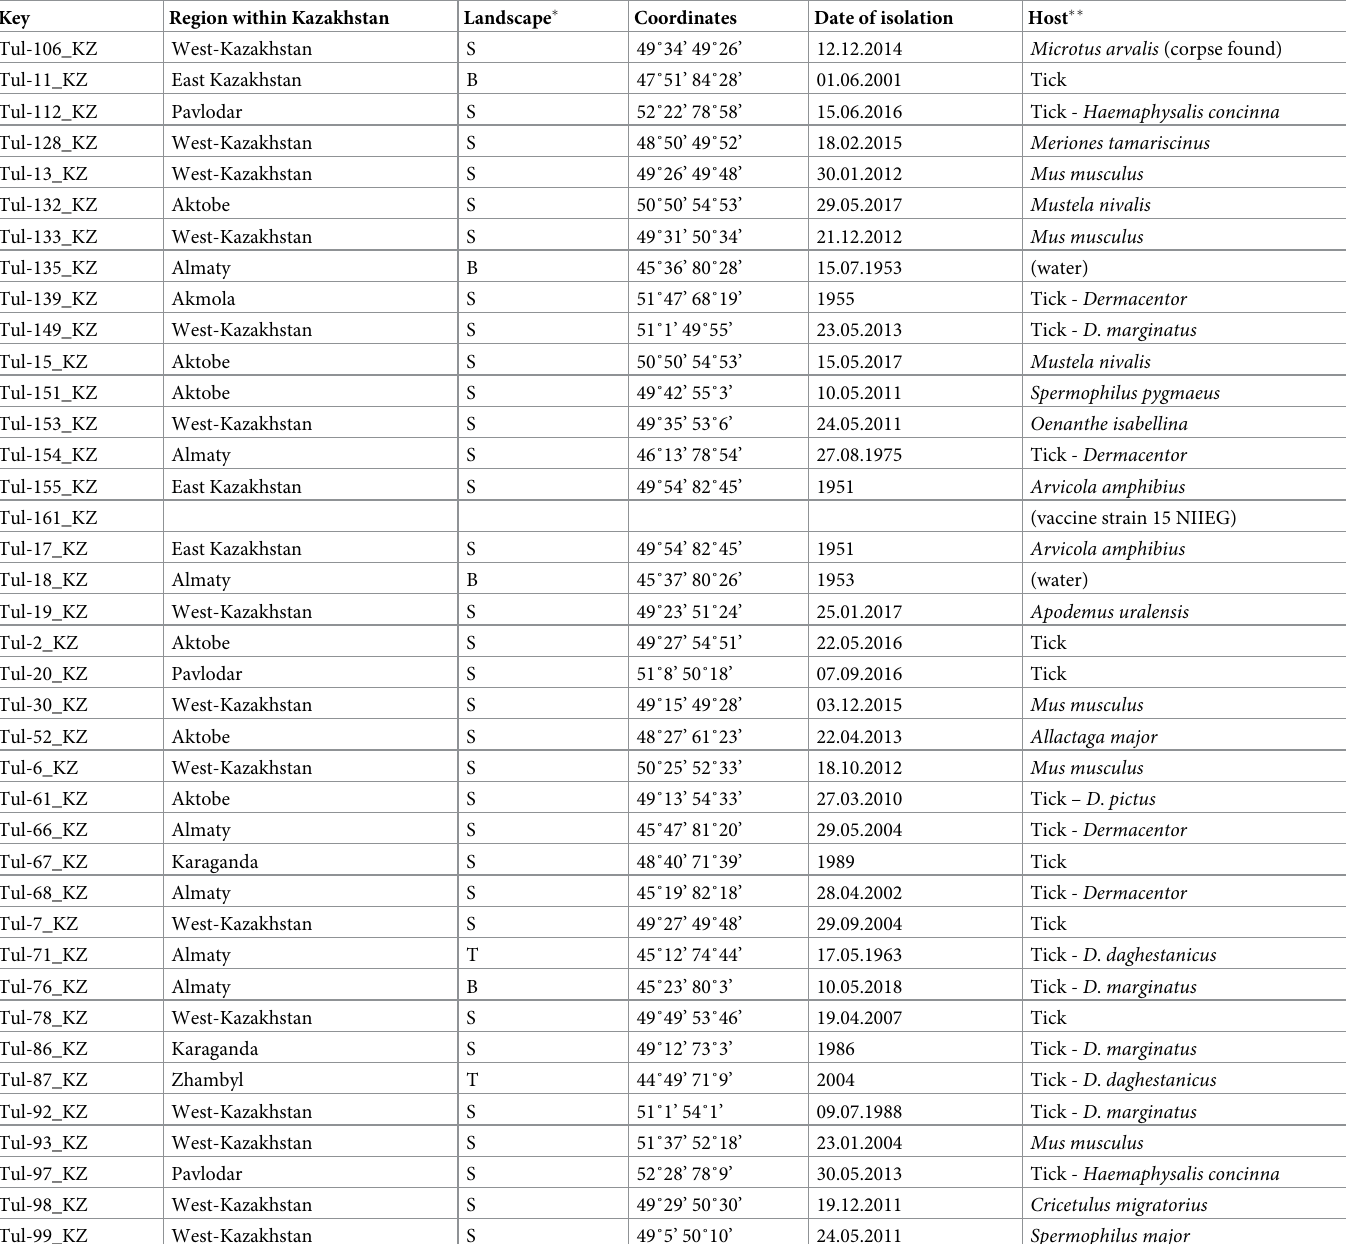
Table 1. Characterization of F. tularensis subsp. holarctica strains from